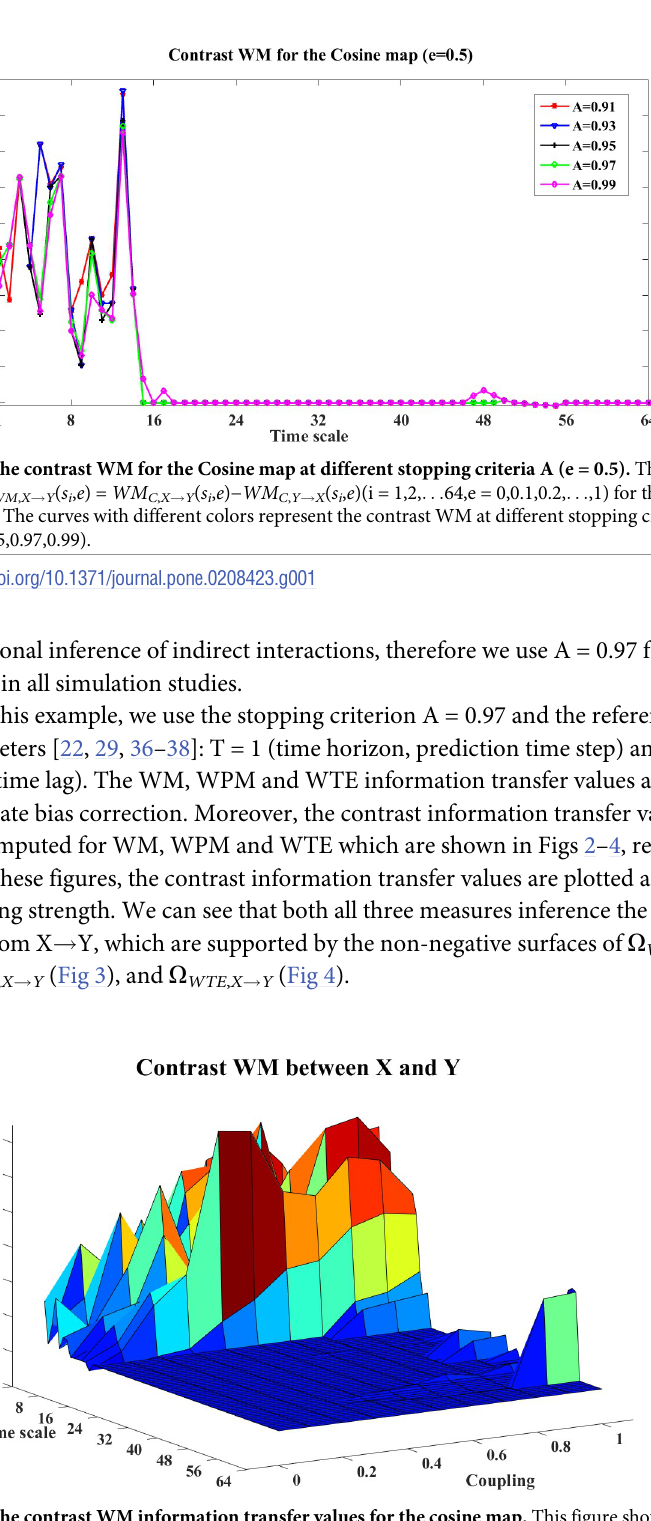
and coupling strength e. i